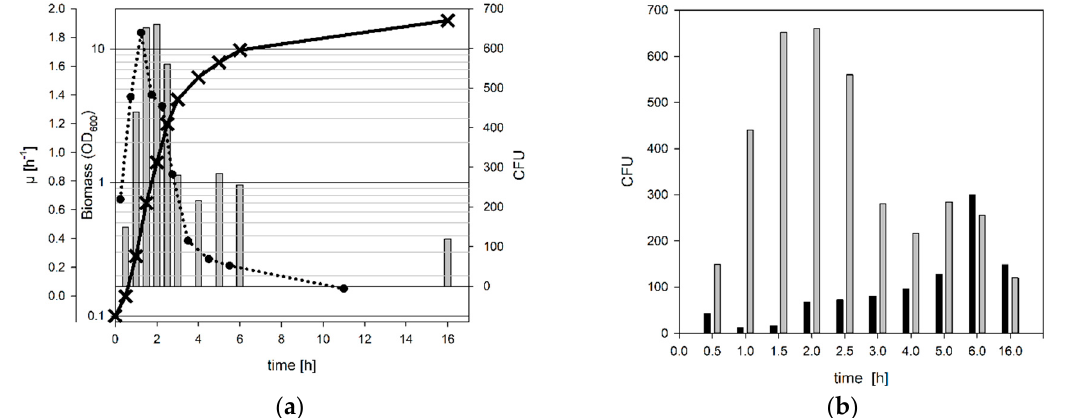
Figure 3. E. coli BW25113 was grown in TY medium, equal numbers of cells were harvested at different time points, competent cells were prepared and transformed with 1 ng pUC19 as described in materials and methods. ( a ) Black line: growth curve; dotted line: growth rate [h − 1 ]; grey bars: number of transformants. Resulting colonies were counted after overnight incubation at 37 °C. A correlation between transformation efficiency and growth rate can be detected ( b ) grey bars: number of transformants; black bars: number of satellite colonies. Comparison of transformants and satellite colonies obtained after transformation of competent cells as in ( a ). A lower number of satellite colonies indicates higher quality of the competent cells.